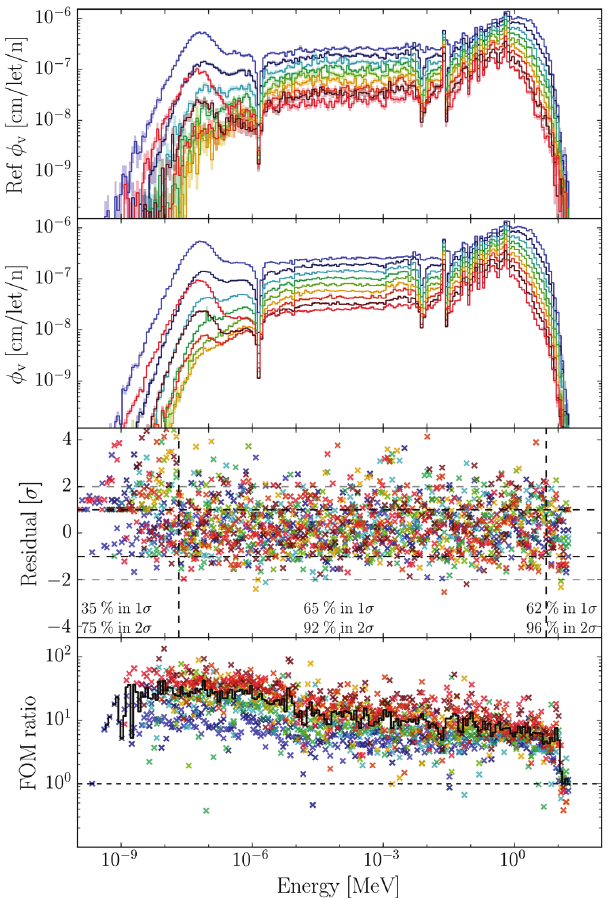
Fig. 6. Neutron flux using a color gradient from blue to red when increasing the radial position of the dosimeter: without biasing as reference (top), with biasing (2nd line), residual (3rd line) and figure of merit (last line) with the average in black.